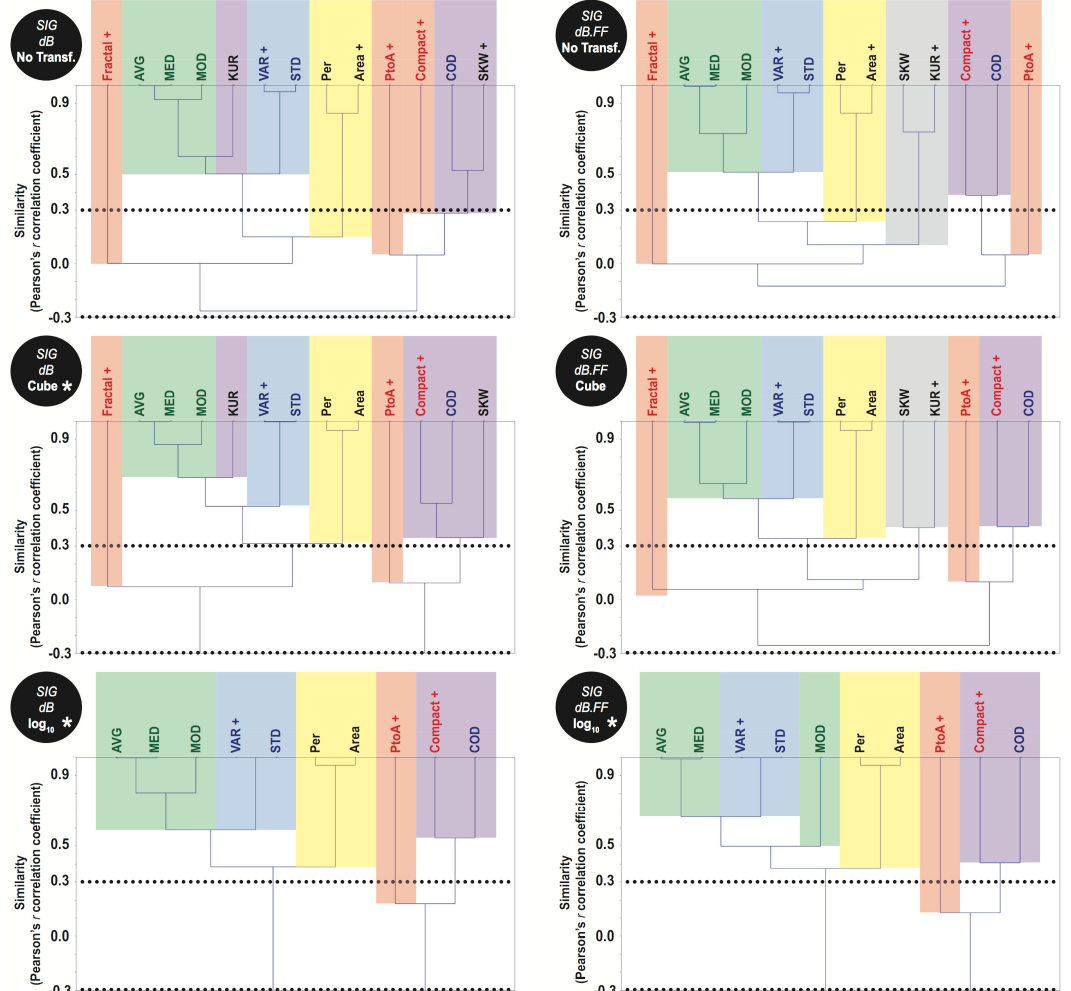
Figure 5. Unweighted pair group method with arithmetic mean (UPGMA) dendrogram analyses for sigma–naught ( σ ◦ ) given in decibel ( dB ), without (left) and with (right) a despeckle filter ( FF ; for Frost filter [62]), for the tested non-linear transformations: none (top), cube root (middle), and log 10 (bottom). Dotted lines: strict similarity phenon thresholds ( r = 0.3 and − 0.3). Yellow and red: size information (basic morphological characteristics and their ratios, respectively). Green and blue: SAR basic qualitative-quantitative statistics (central tendencies and dispersion, respectively). Gray: pixel distribution metrics. Purple: undefined group. Uncorrelated variables ( + ) selected in our current research; see also Table 4. The (*) indicates the requirement of a second round of dendrogram analysis; see Section 3.2. For an explanation of the attributes, see Section 3.1.